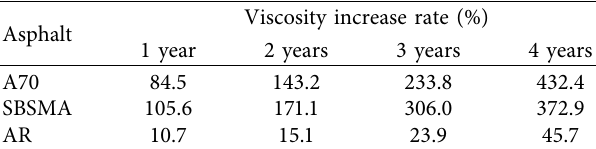
Table 5: Viscosity change rate of